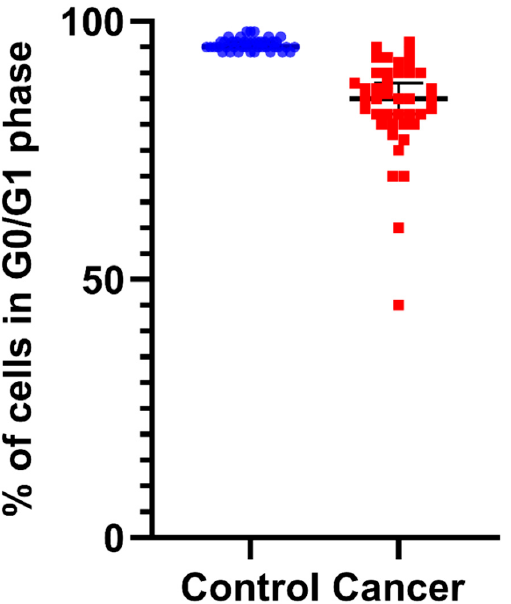
Figure 3. The percentage of cells in G0/G1 in normal control samples versus tumor cells, as quantified by iFC: Percentages of cells in G0/G1 are presented as blue or red dots—for normal and cancer tissue, respectively—in individual patient samples. Median G0/G1 percentages are shown as horizontal lines in each group. There is a significant difference between the two distributions, with cancers cells exhibiting a significantly lower percentage in the G0/G1 cell-cycle phase.